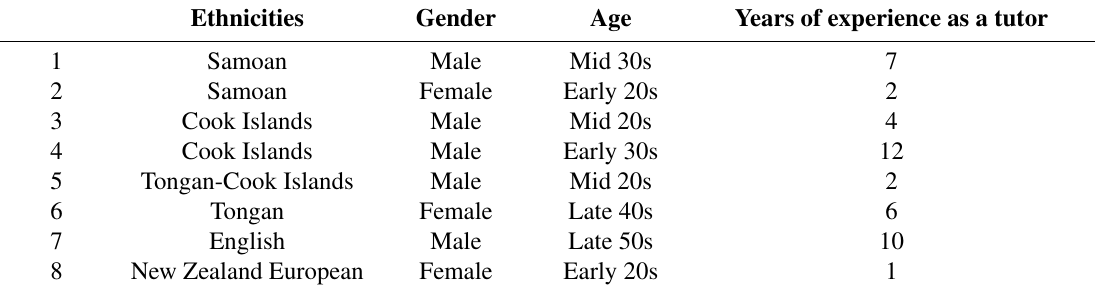
Table 1. Research